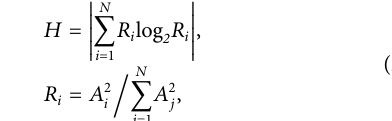
FIGURE 16 Process of improved spectral subtraction.